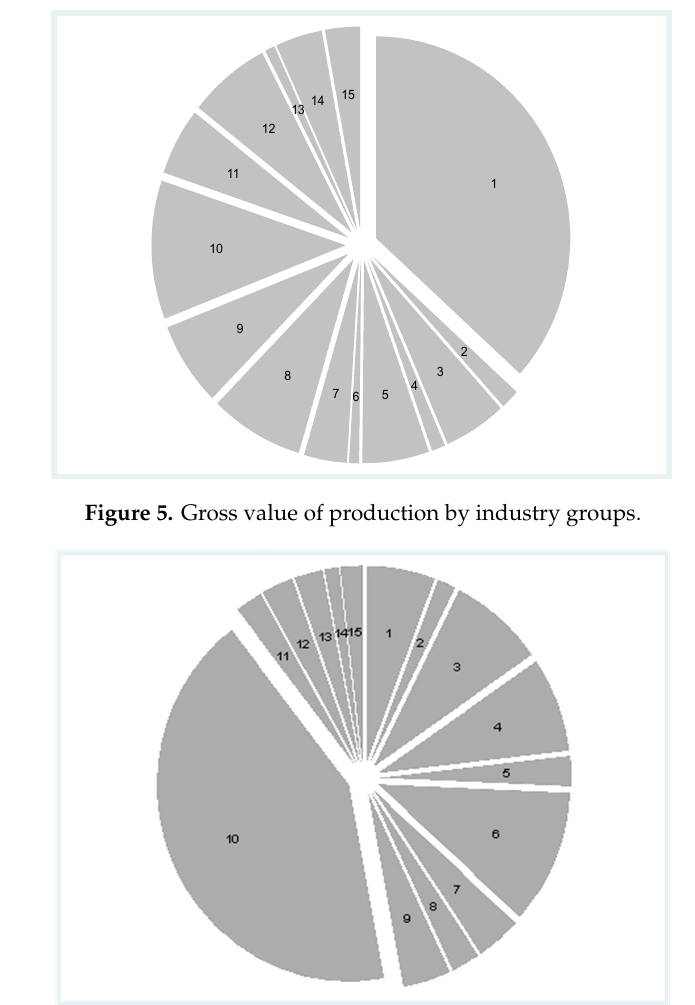
Figure 6. Energy use across industry groups.